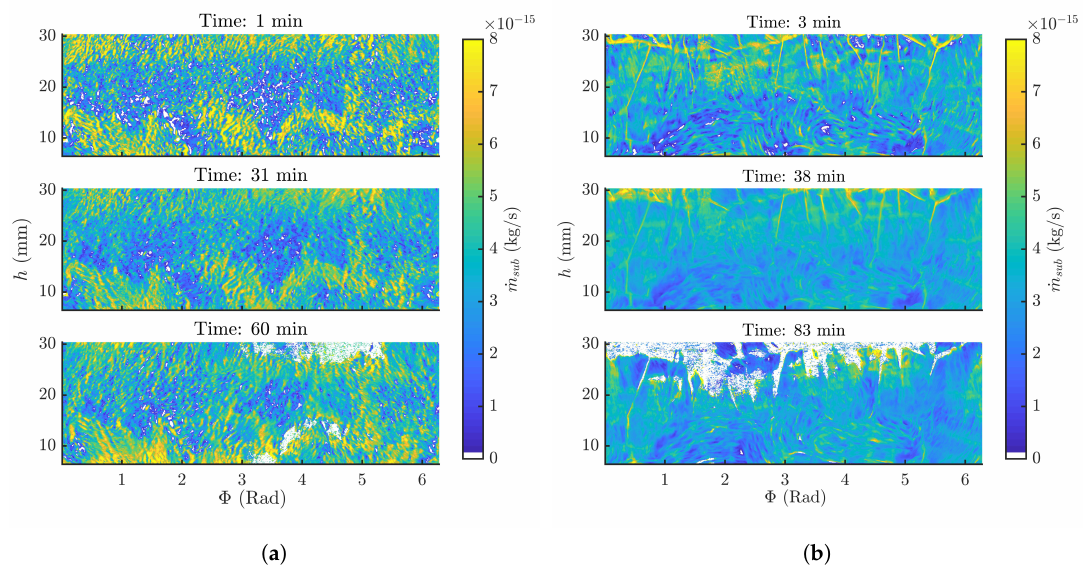
Figure 6. ( a ) Sublimation rate ( ˙ m sub ) for every ( Φ , h ) coordinate in function of time of a 3% mannitol formulation during spin freeze-drying. ( b ) Sublimation rate ( ˙ m sub ) per ( Φ , h ) coordinate in function of time of a 4% BSA formulation during spin